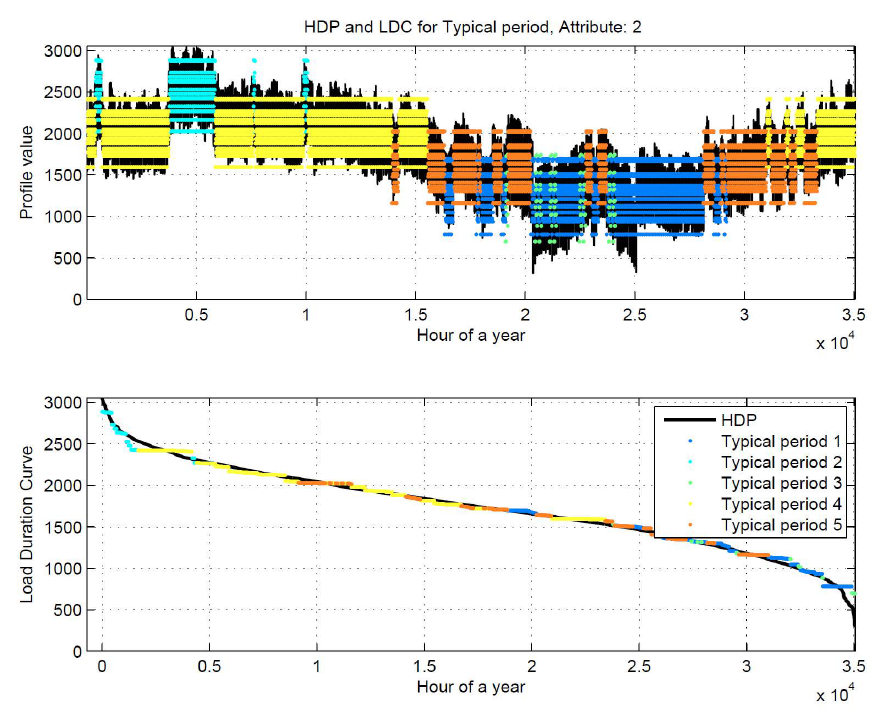
Figure 21. Power profile and duration curves, represented with the 35,040 datapoints (black curve) and five typical days (other